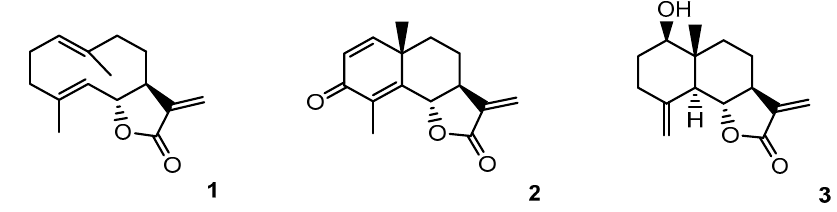
Figure 1. Chemical structure of compounds isolated from Laurus azorica Figure 26. Chemical structure of compounds isolated from Laurus azorica leaves.